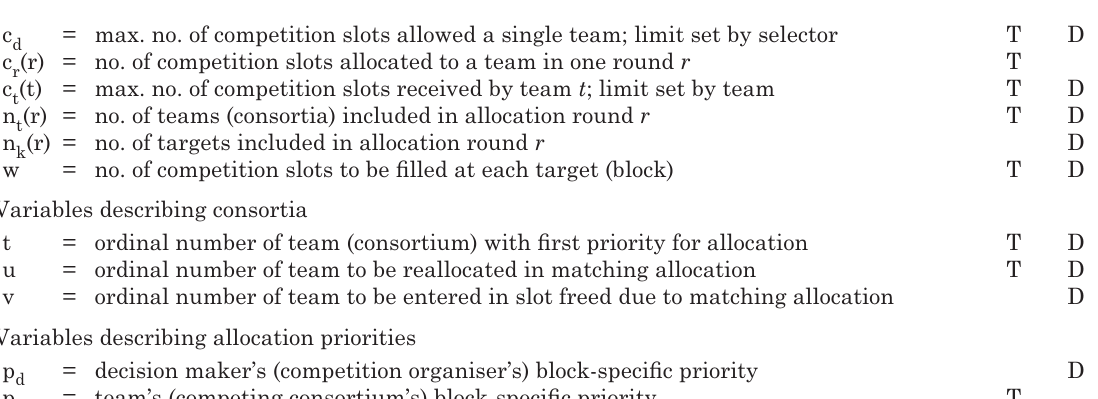
Table 2. Variables of allocation algorithms (related to Figures 3 and 4 below) Variables whose values the user (decision maker) selects for implementing